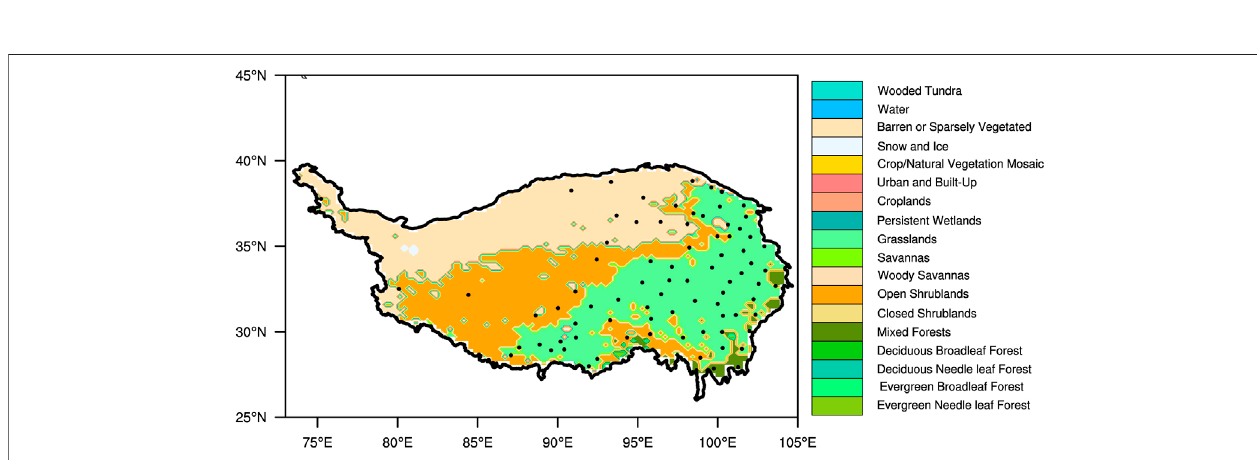
FIGURE 1 | The location of the Qinghai-Tibet Plateau (QTP) in China, and the distribution of Elevation (Unit: m). The 824 automatic weather stations (symbol) in China including 80 automatic weather stations in the QTP.